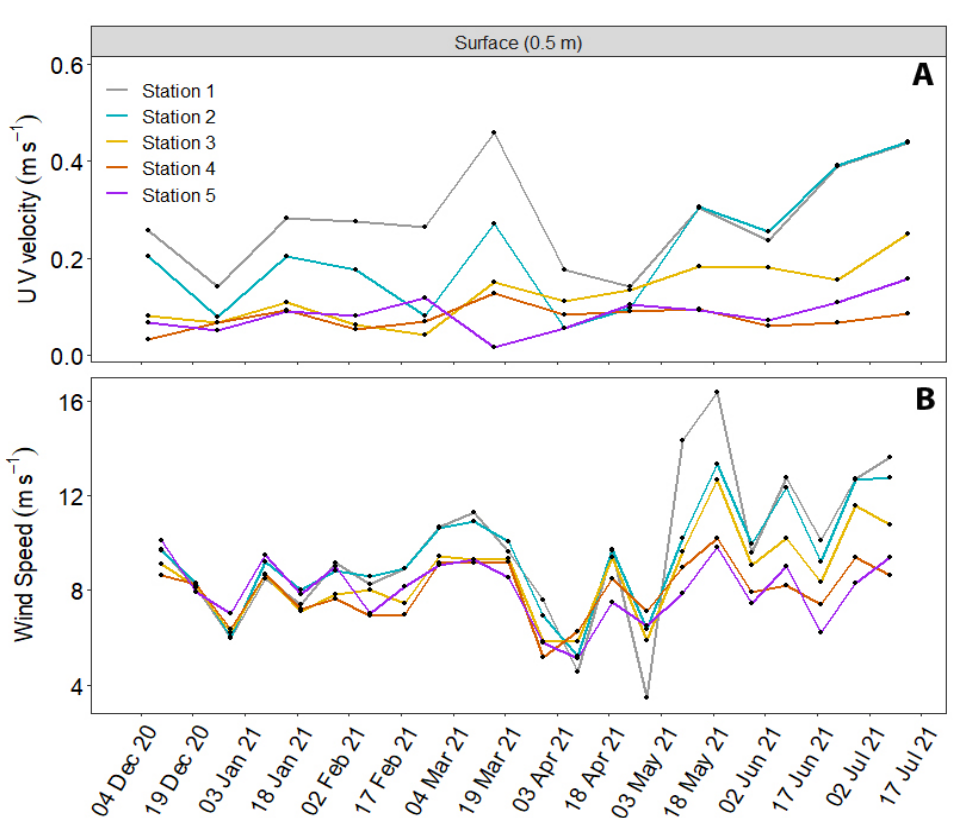
Figure 6. ( A ) Total component of current velocity (m · s − 1 ) and ( B ) wind speed (m · s − 1 ) from December 2020 to July 2021. Data were download through the Copernicus Marine platform. The velocity of the current due to the filament and the anticyclonic eddy was higher at Stations 1 and 2 near Gran Canaria Island during the stranding event (2 June 2021).